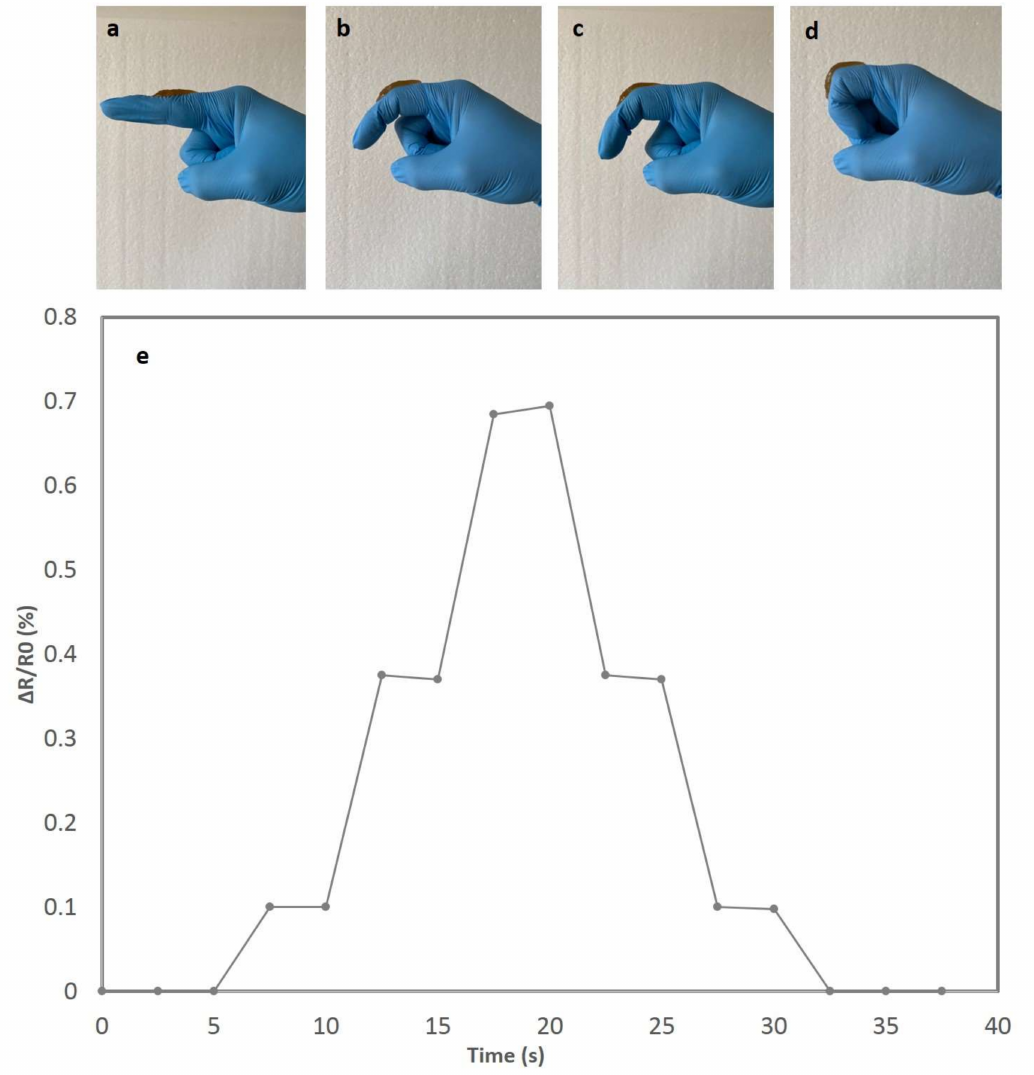
Figure 7. ( a–d ) Adhered 1 wt.% TA-ChNFs hydrogel to the first author’s forefinger while bending to approximate angles and ( e ) its relative resistance change in real